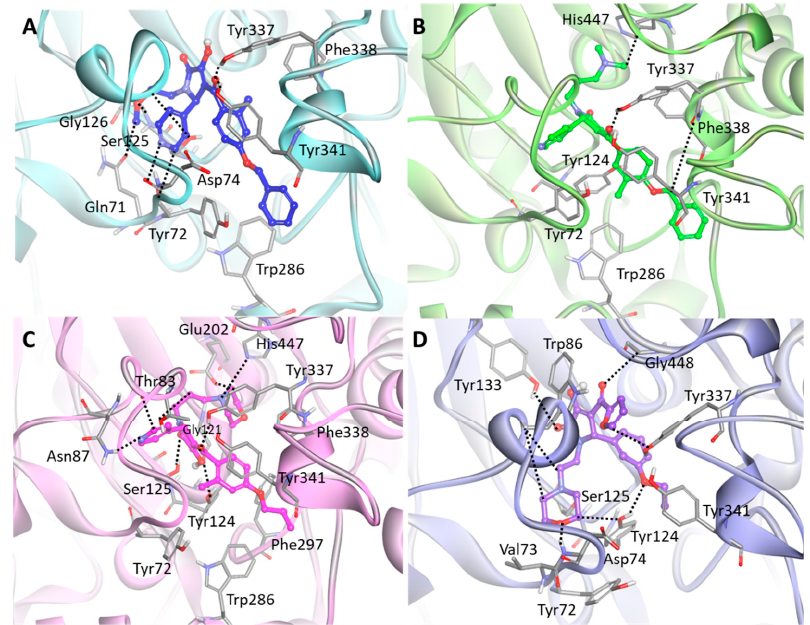
Figure 7. Binding mode of the final hit compounds at the active site of hAChE. ( A ) Hit 1 ( B ) Hit 2 ( C ) Hit 3 ( D ) Hit 4. Each hit compound was drawn as blue, green, magenta, and purple stick model. The interacting residues are shown as gray stick models. Hydrogen bonds between hAChE and the compound are indicated as black dashed lines. Only polar hydrogens are shown for clarity.